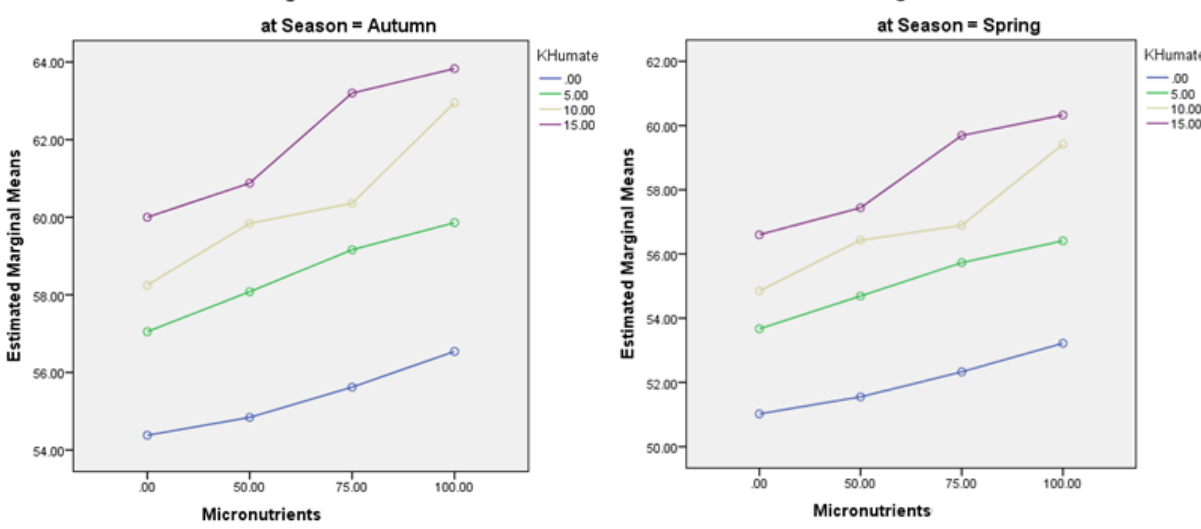
Figure 2. Interaction graphs for total fruit yield obtained under K-humate and micronutrients mixture applied in the autumn and spring seasons. Table 4. Harvesting index of tomato as affected by various levels of K-humate and MC under the field conditions during